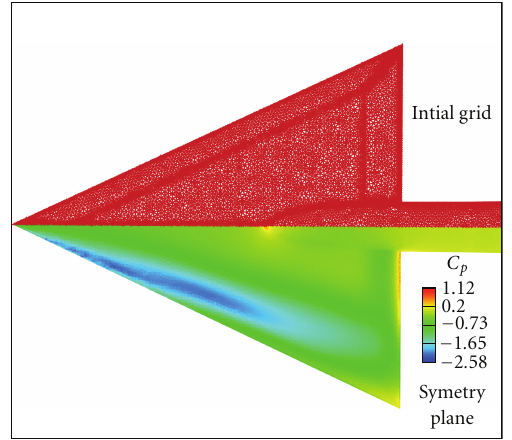
Figure 8: Initial (unadapted) upper surface mesh and Euler inviscid solution on the sharp leading-edge delta wing at M ∞ = 0 . 4, α = 20 . 3 ◦ .